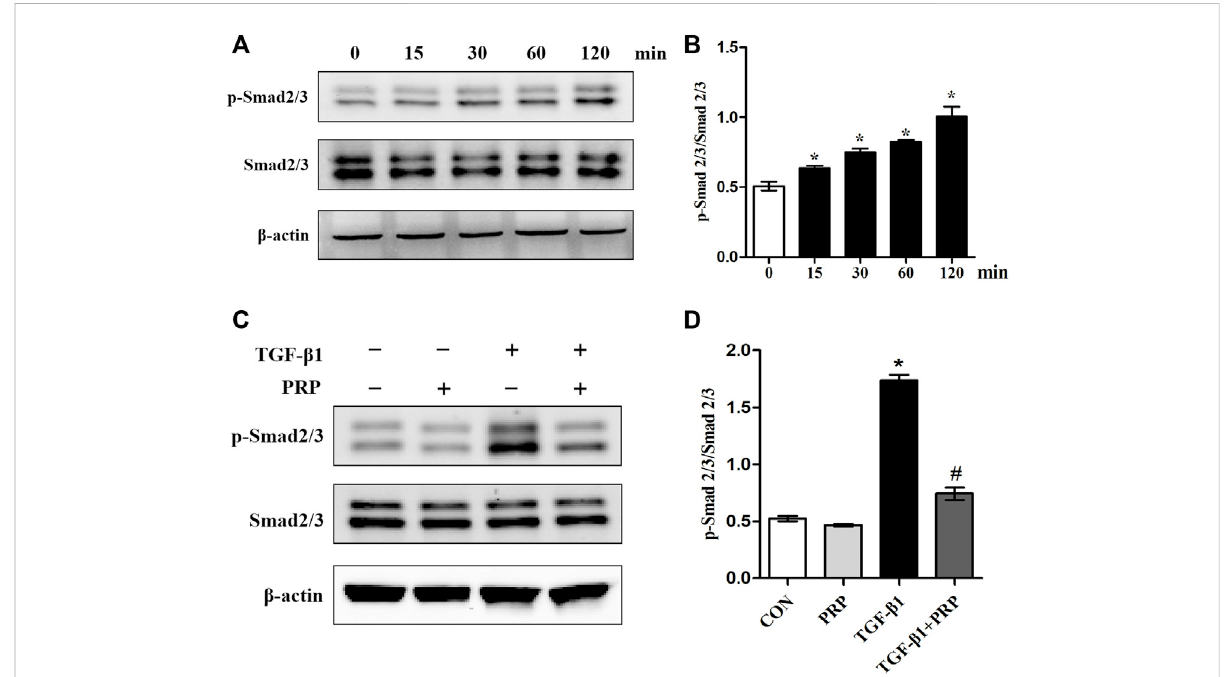
FIGURE 3 Effects of PRP on the activation of Smad2/3 signaling. (A) Western blot analysis the activation of fi brosis-associated signaling Smad2/3 after fi broblasts treated with 10 ng/ml TGF- β 1 for 0, 15,30, 60, and 120 min, respectively. (B) The bargraphs represent therelativeexpressionof pSmad2/ 3/Smad2/3. * p < 0.05 compared with the 0 group. (C) Western blot analysis the activation of fi brosis-associated signaling Smad2/3 after fi broblasts treated with 10 ng/ml TGF- β 1 combined with PRP. (D) The bar graphs represent the relative expression of pSmad2/3/Smad2/3. Error